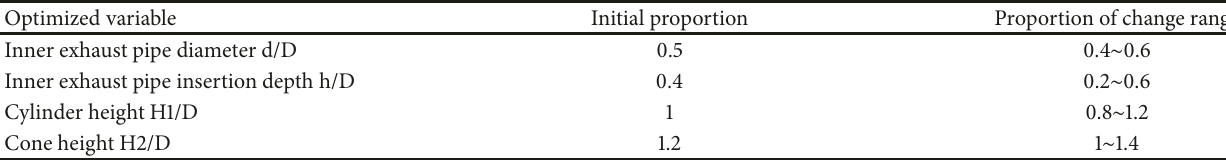
Table 3: Ratio change range of optimization parameter.